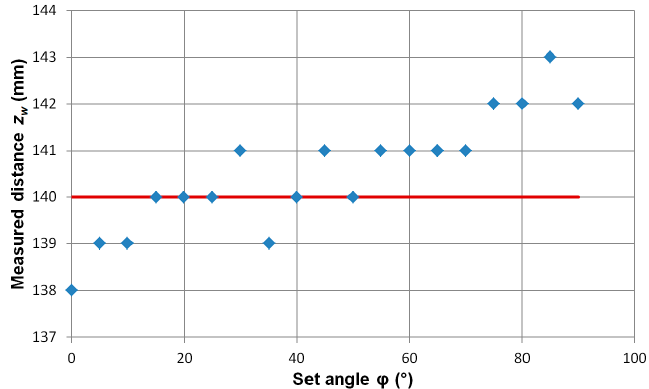
Figure7. Dependenceofthedetermineddistancevaluefromtheobjectonthesetangle ϕ . Setcoordinates Figure 7. Dependence of the determined distance value from the object on the set angle φ . Set of the ME8 standard ( x 0 , y 0 , z 0 ) = (0, 0, 140) mm. Red line—the set value z 0 of the coordinates of the ME8 standard ( x 0 , y 0 , z 0 ) = (0, 0, 140) mm. Red line - the set value z 0 of the object.